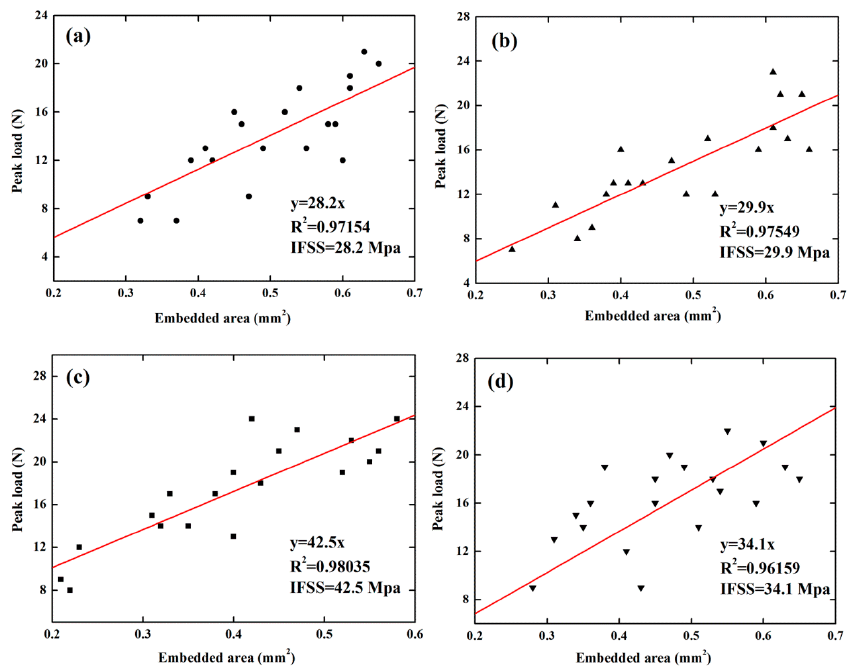
Figure 10. IFFS results: ( a ) untreated bamboo fibers, ( b ) 2 wt.% NaOH treated bamboo fibers, ( c ) 6 wt.% NaOH treated bamboo fibers, and ( d ) 10 wt.% NaOH treated bamboo fibers.